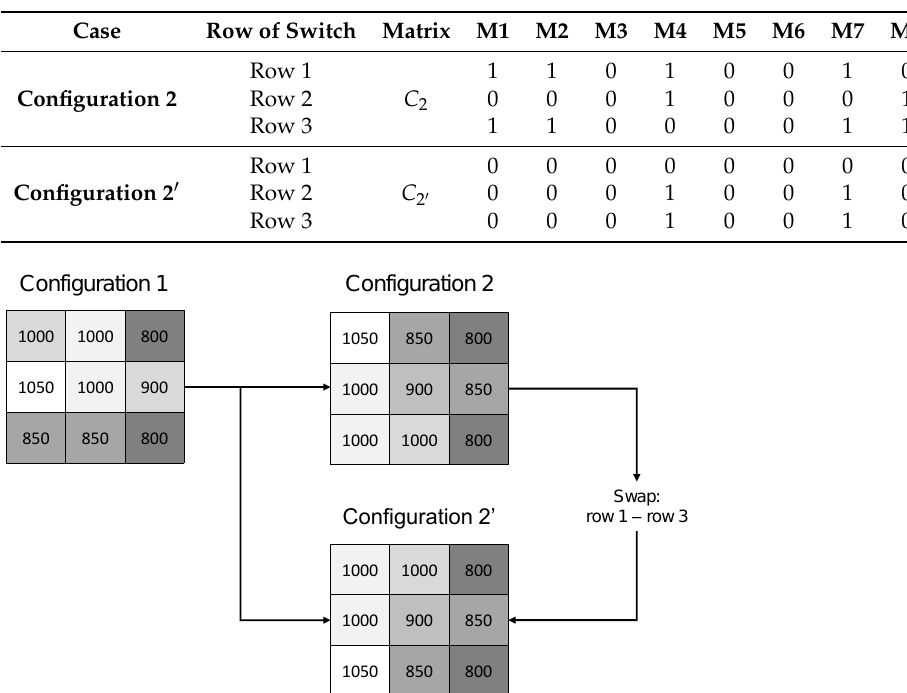
Table 1. Matrix of operating switches C 2 and C 2 (cid:48) corresponding to two optimal configurations 2 and 2 (cid:48)